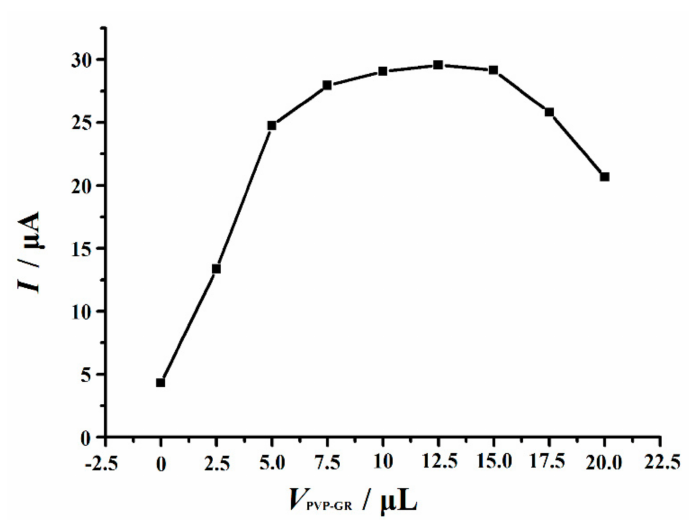
Figure 5. E ff ect of the amount of the PVP-GR suspension on the oxidation peak current of 10 µ M